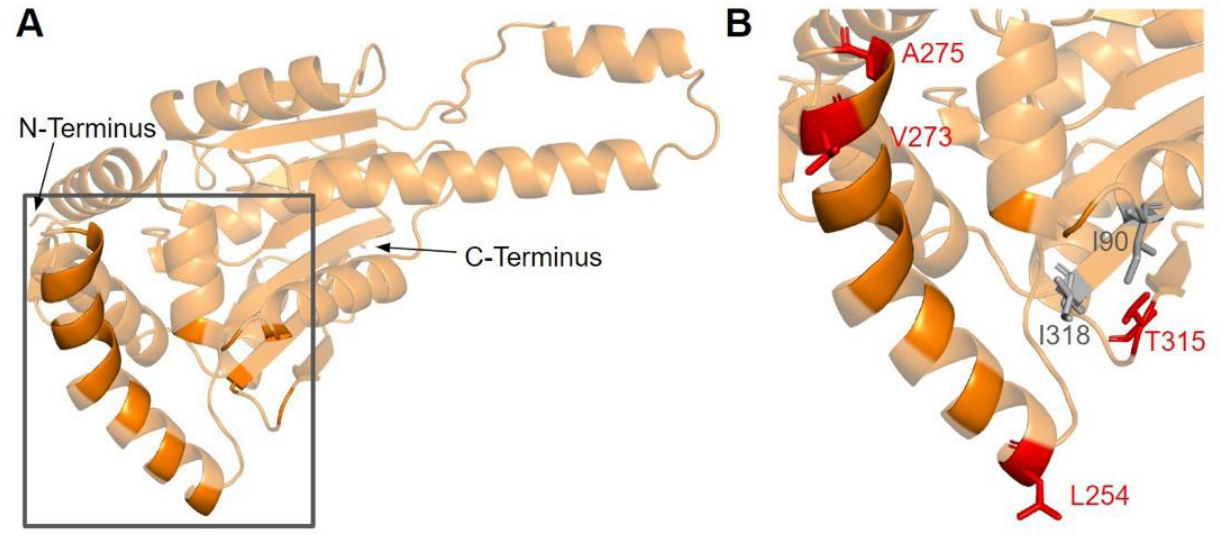
Figure 17. SNVs found in the COQ5 dimerization interface. ( A ) The dimerization interface of COQ5 largely consists of hydrophobic residues located on the α6 helix (left highlight). The first 47 residues were truncated for simplicity. ( B ) Locations of SNVs are depicted. Residues are colored according to their corresponding SNVs in Figure 12.